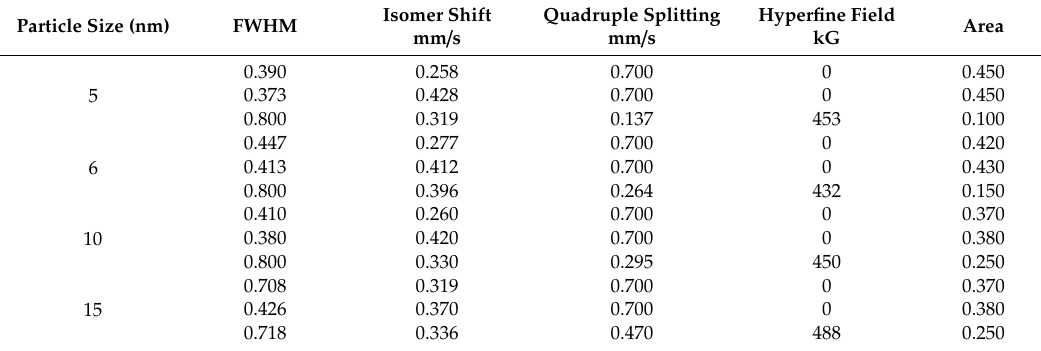
Figure 7. Mössbauer spectra of MnFe 2 O 4 nanoparticles in the as-dried condition for different nanoparticle sizes measured at room temperature and without any applied magnetic field ( a ) 5 nm, ( b ) 6 nm, ( c ) 10 nm, and ( d ) 15 nm. In the spectrum, hollow red circles represent experimental data, the solid red line represents theoretical fitting, and the other three lines represent sub spectra of three subspecies named a, b, and c to fit the data. Table 1. Hyperfine parameters of MnFe 2 O 4 nanoparticles with different pH without magnetic field and at room temperature.